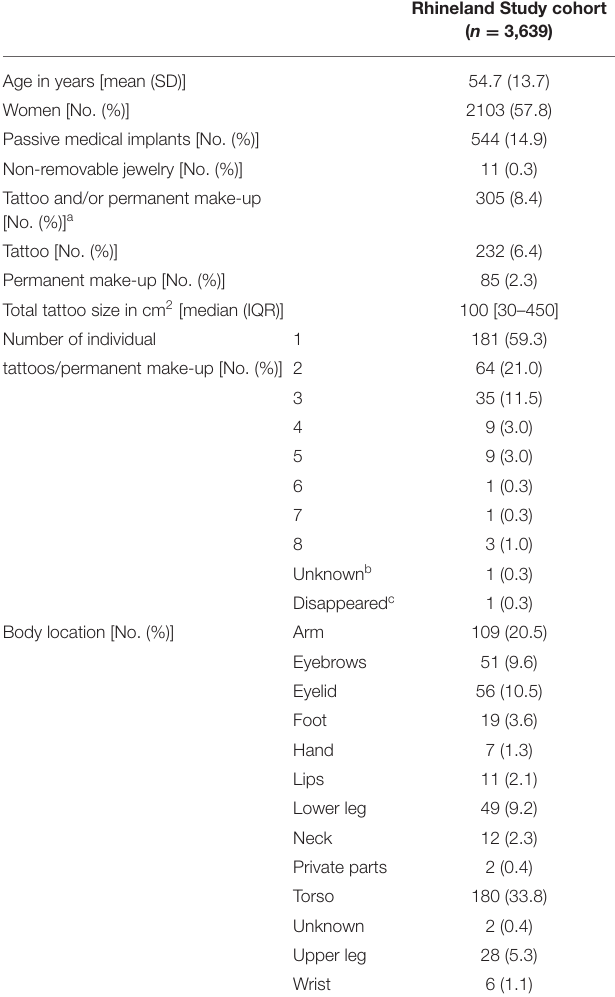
TABLE 1 | Characteristics of the participants of the Rhineland Study who underwent